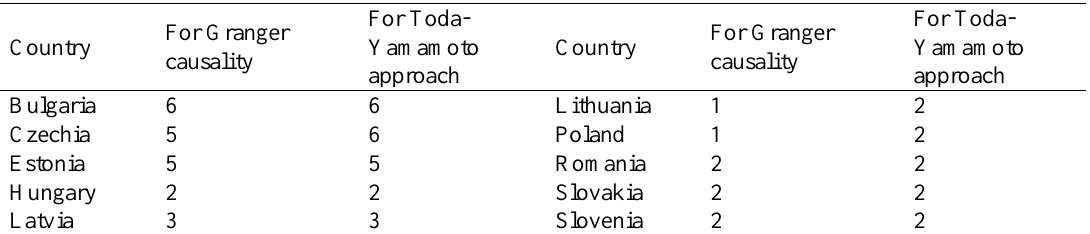
Table 3. Optimum VAR